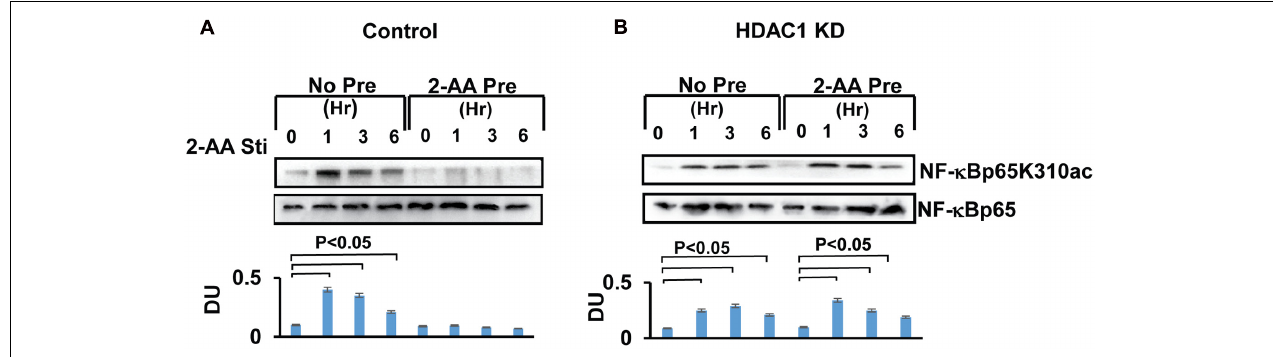
FIGURE 3 | 2-AA tolerization decreases the acetylation of NF- κ Bp65. Immunoblot showing decreased NF- κ Bp65K310 acetylation in 2-AA-tolerized RAW264.7 cells (A) . HDAC1 KD restored NF- κ Bp65K310 acetylation in 2-AA-tolerized cells following 2-AA stimulation (B ). Data are representative of three independent experiments. An asterisk ( ∗ ) indicates significant difference from untreated cells ( P < 0.05). DU, densitometry units, bars represent